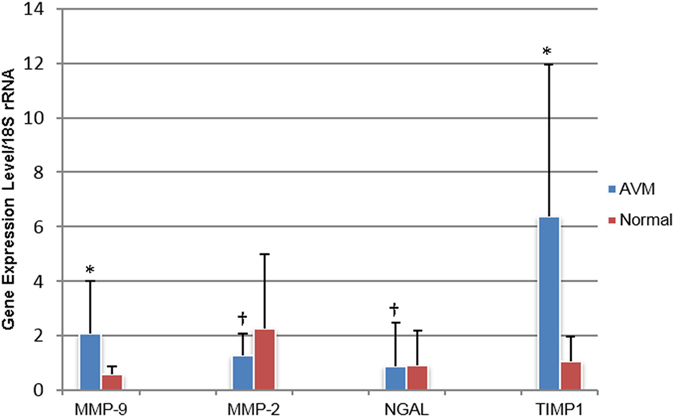
Messenger RNA expression profile.Comparison of mRNA expression levels of MMP-9, MMP-2, NGAL and TIMP-1 between AVMs and normal tissues. *significant difference; †no significant difference; M/T, MMP-9/TIMP-1 complex; M/N, MMP-9/NGAL complex.